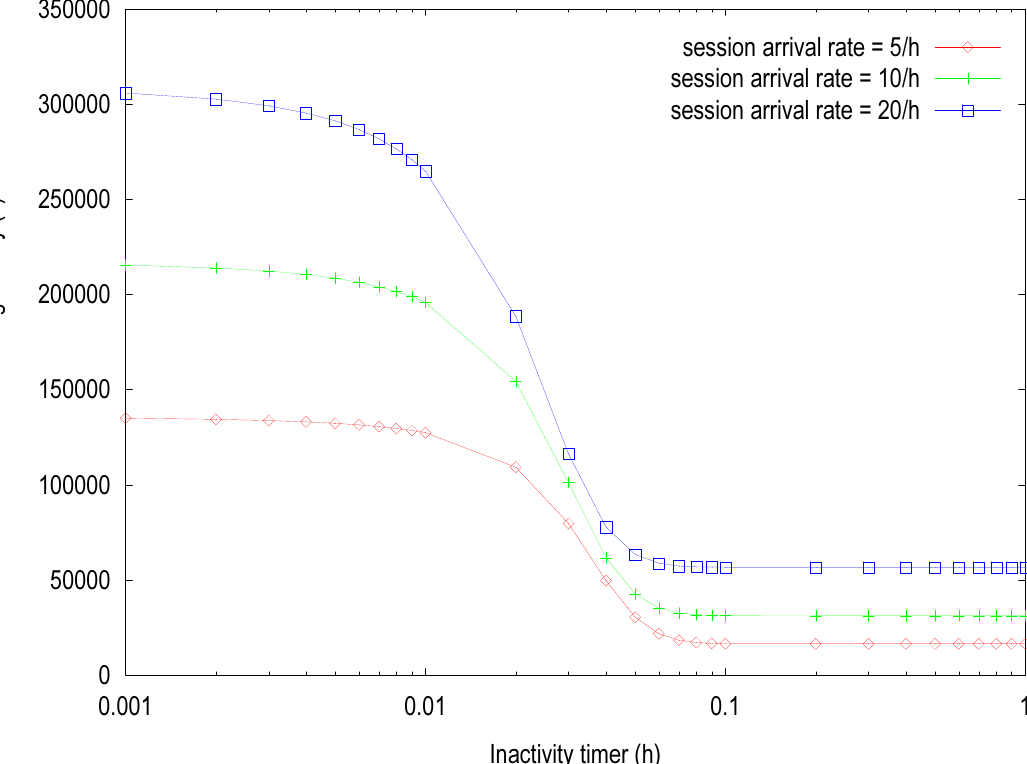
Figure 7. Cumulative average delay by varying the session arrival rate (large values of T and T E W